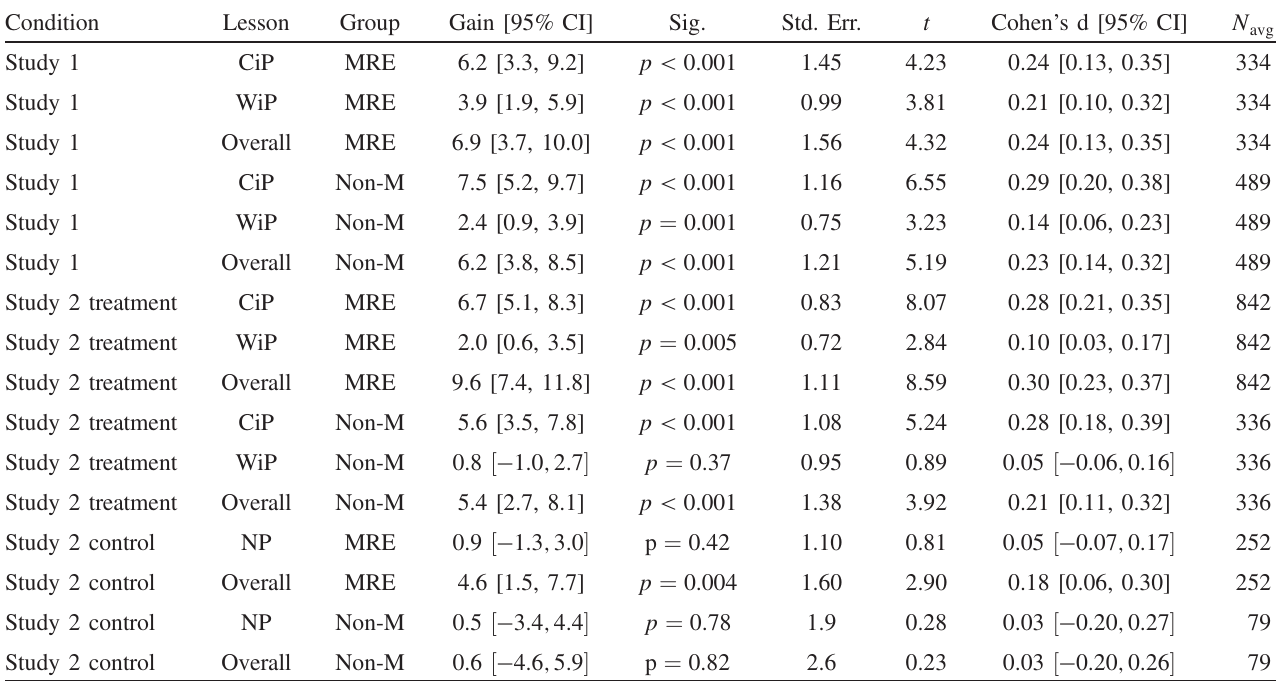
TABLE XIII. Summary of paired t tests based on MRE-identification (MRE-identified or non-MRE-identified) for Study 1 and Study 2 (treatment and control groups). Each row represents the paired t test after combining 100 multiply imputed data sets according to Rubin ’ s